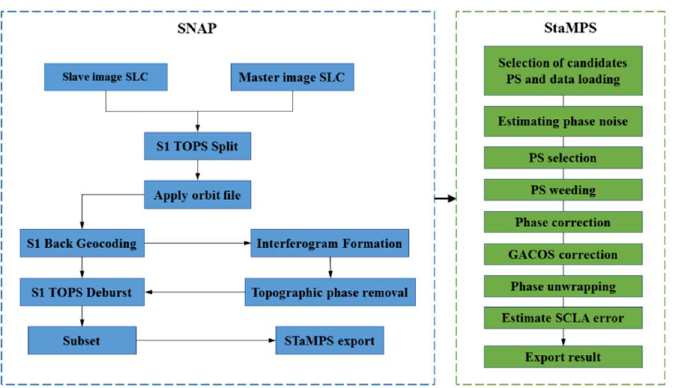
Figure 4. The flowchart of the whole PSI processing chain, using SNAP program and StaMPS algorithm (adapted from [5]).